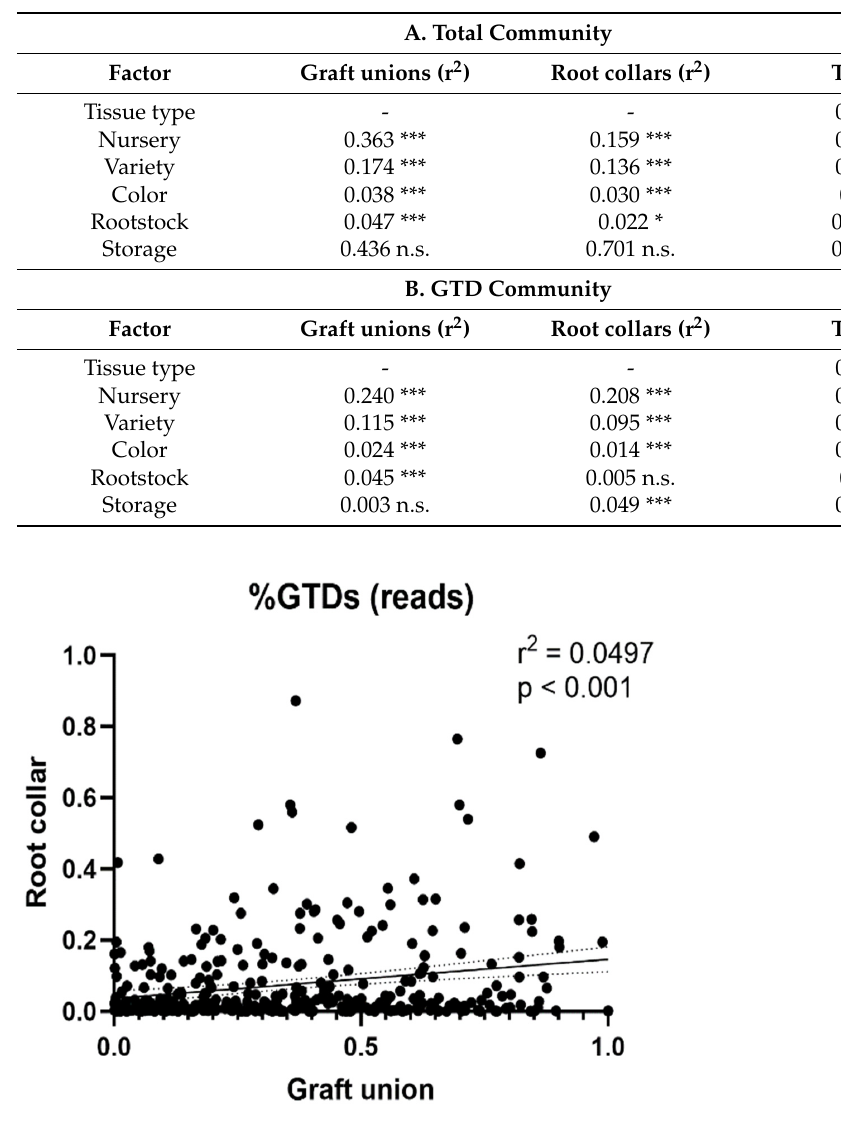
Table 3. Contribution of nursery, variety, color, rootstock, and storage to ( A ) total community variation in graft unions, root collars, and both tissues combined (total), compared that of ( B ) only GTDs. Annotation next to the numbers indicates significance level: *** <0.001, ** <0.01, * <0.05, n.s. = not significant (>0.05).